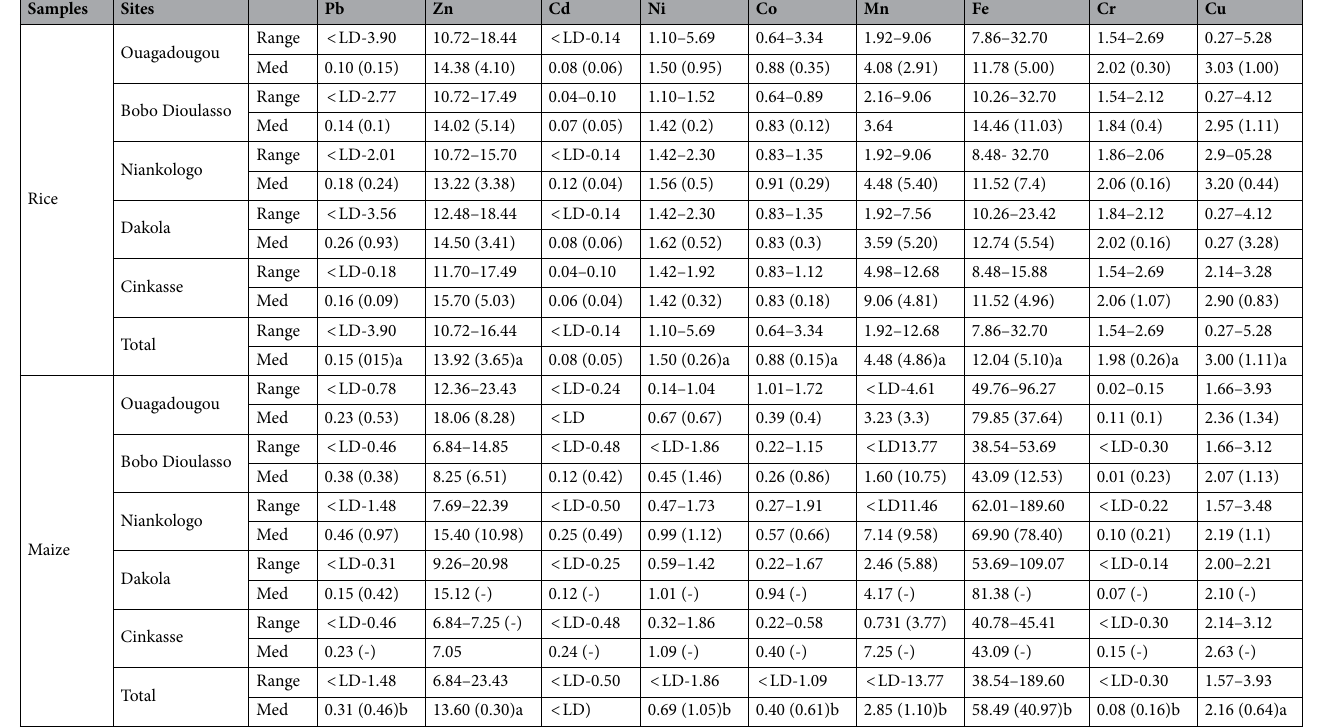
Table 1. Metallic trace elements contents in cereals